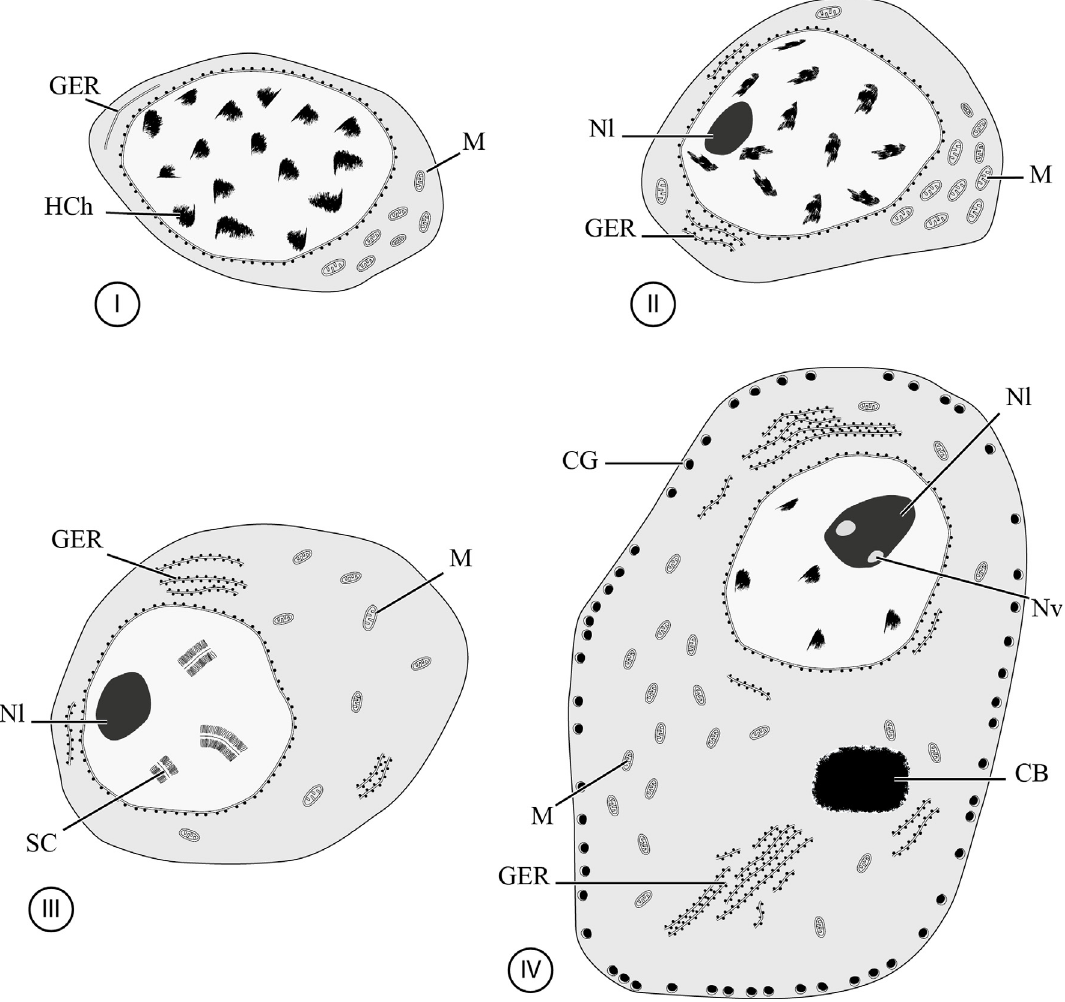
Figure 16. Diagram showing the four stages (I–IV) of the oogenesis of Crepidostomum metoecus . CB: chromatoid body; CG: cortical granule; GER: granular endoplasmic reticulum; Hch: heterochromatin; M: mitochondrion; Nl: nucleolus; Nv: nuclear vacuole; SC: synaptonemal